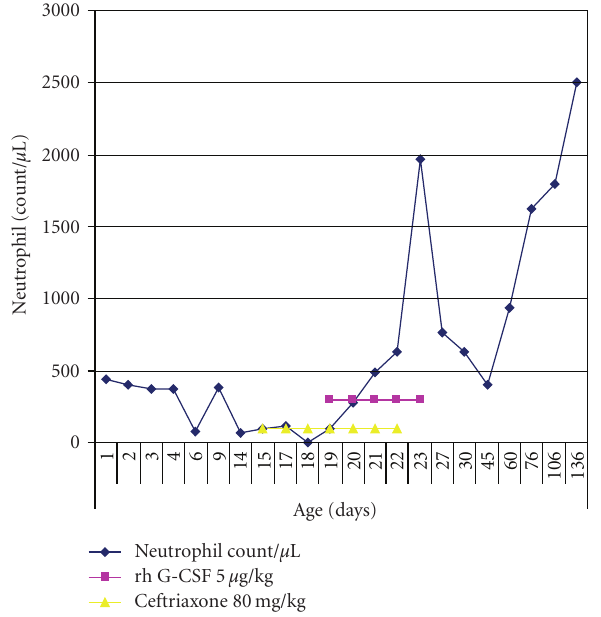
Figure 1: The neonate’s neutrophil count pattern and hr-G-CSF therapy course.